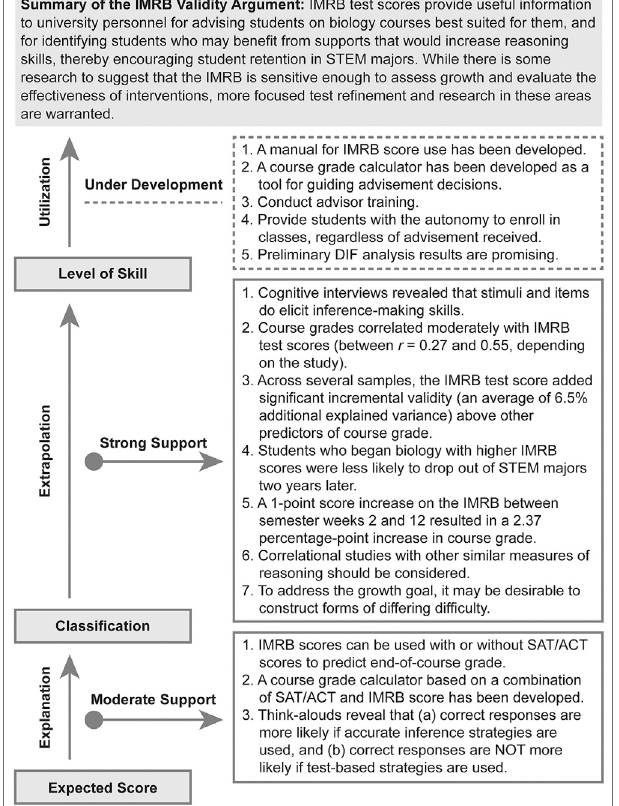
FIGURE 1 | (A). Summary of the IMRB validation research fi